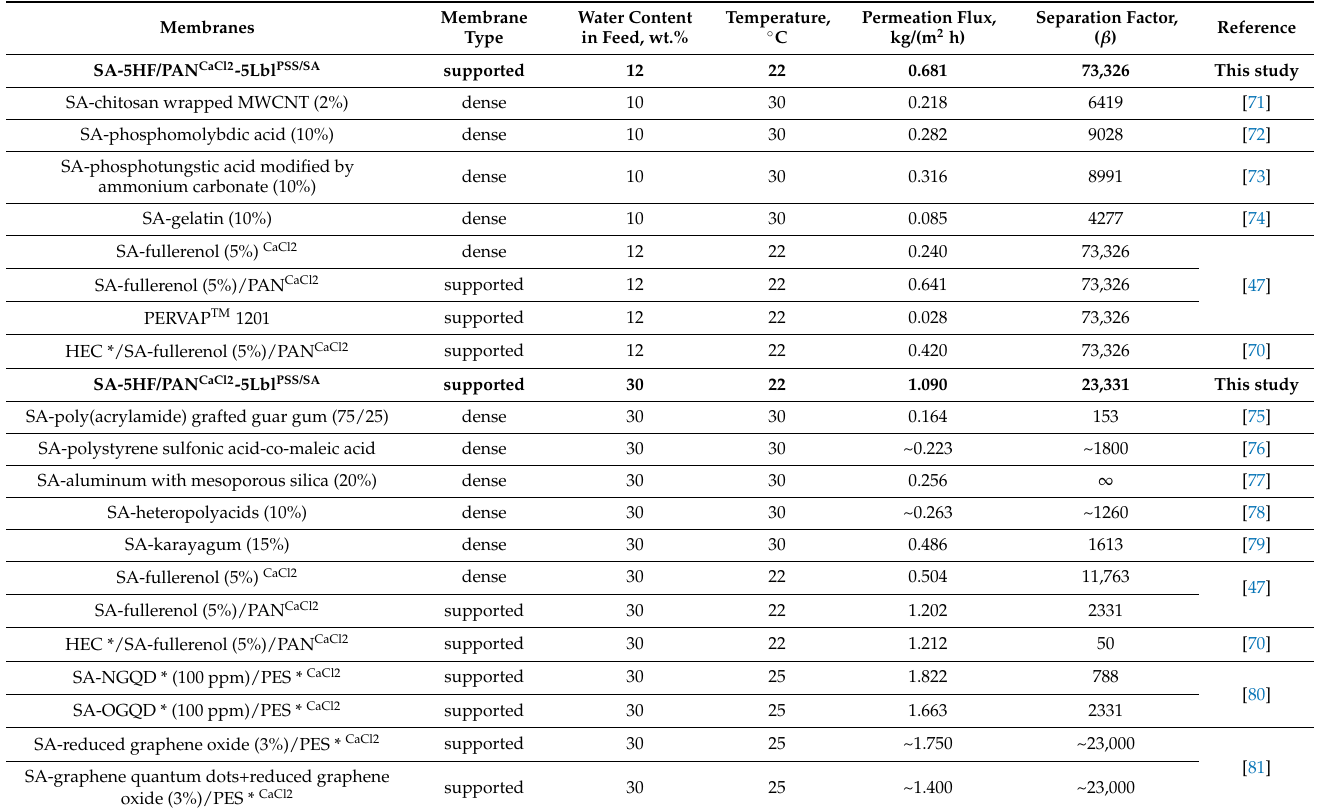
Table 7. Comparison of the transport properties of the SA-based and commercial PERVAP TM 1201 membranes in the pervaporation dehydration of